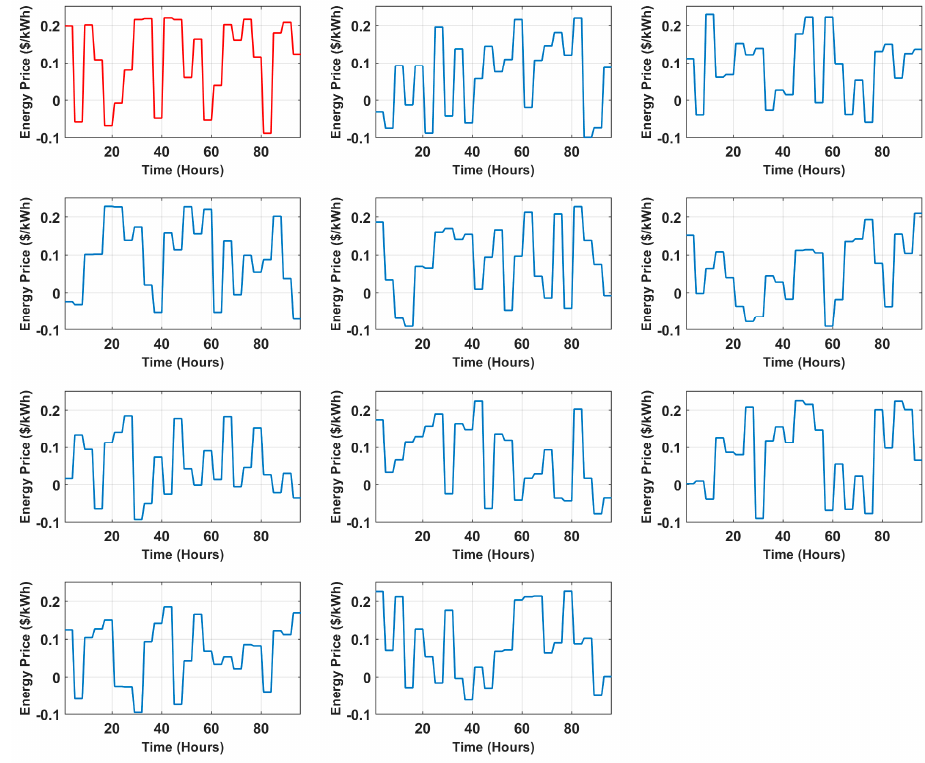
Figure 3. A sample of four days of the real-time pricing profiles used for training, validation, and testing.